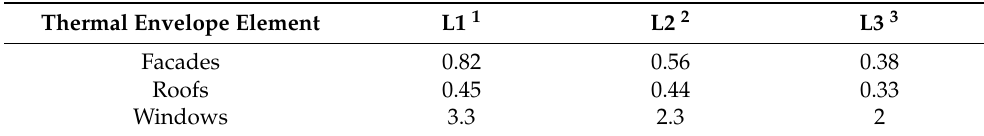
Table 3. Thermal transmittance, U (W/m 2 K), of thermal envelope elements according to different energy demand levels.